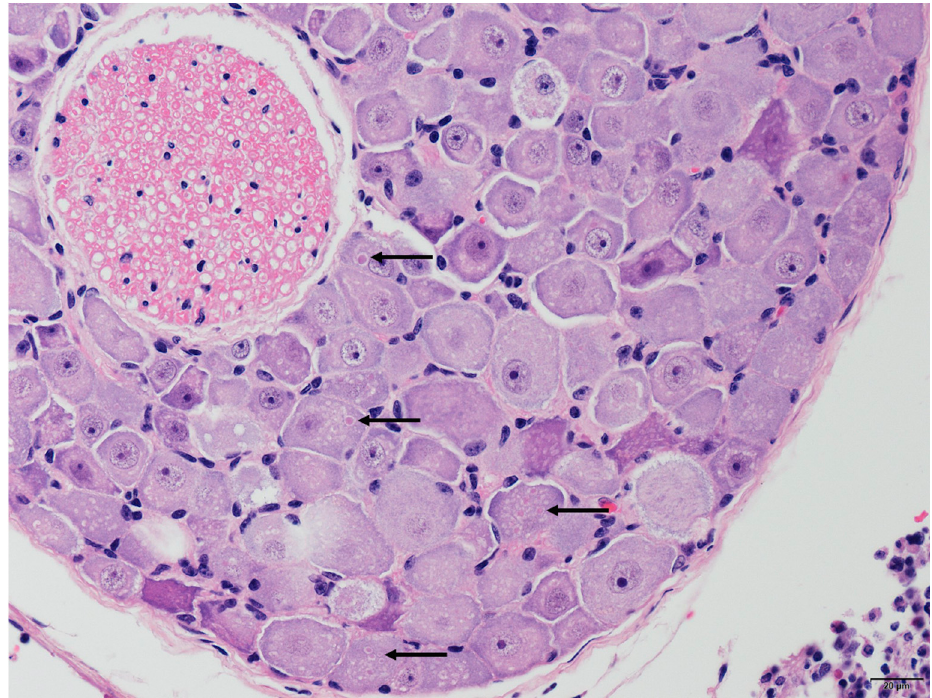
Figure 2. Various sized, ovoid, intracytoplasmic eosinophilic inclusion bodies (Negri bodies, represented by the arrows) were noted in the neurons of the spinal ganglion infected by the Taiwan bat lyssavirus 1 isolate TWBLV-1/KL/2020.